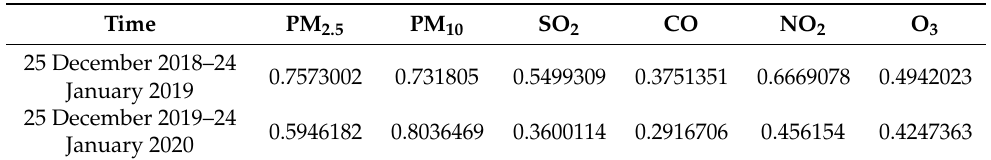
Time PM 2.5 PM 10 SO